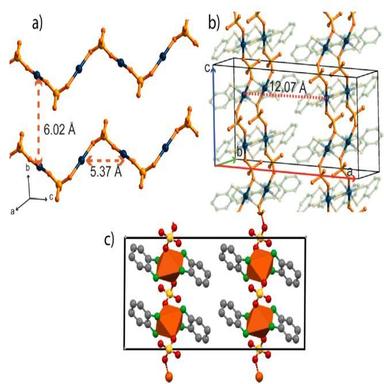
Compound 1: a) isolated polymeric chains, diamine molecules are removed; b) packing of molecules, organic part drawn in light gray; c) A general packing of the crystal structure;. Selected interatomic distances between metal sites are given.